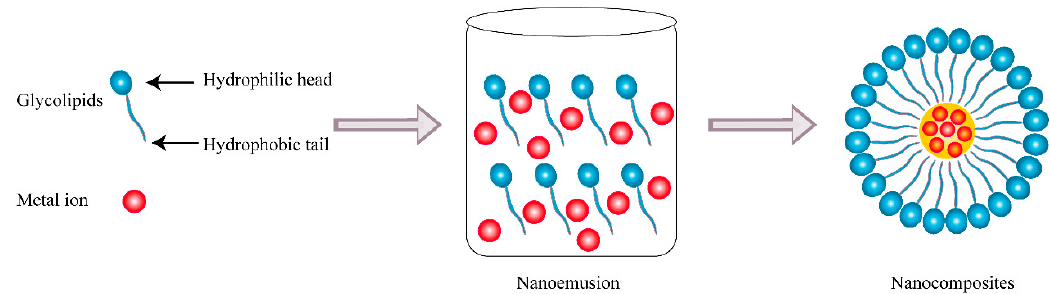
Figure 6. Schematic diagram of the synthetic pathway of nanocomposites based on glycolipids. Table 4. Antimicrobial effects of glycolipid-modified